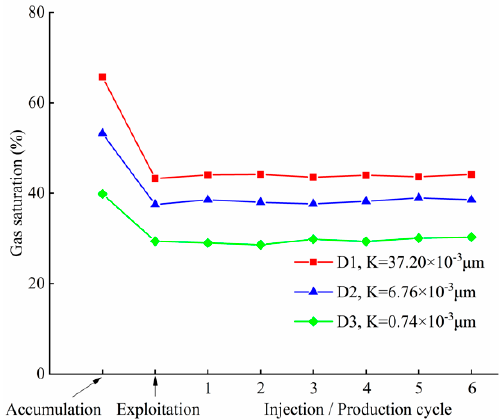
Figure 12. Variation curve of gas saturation in the gas-water transition zone